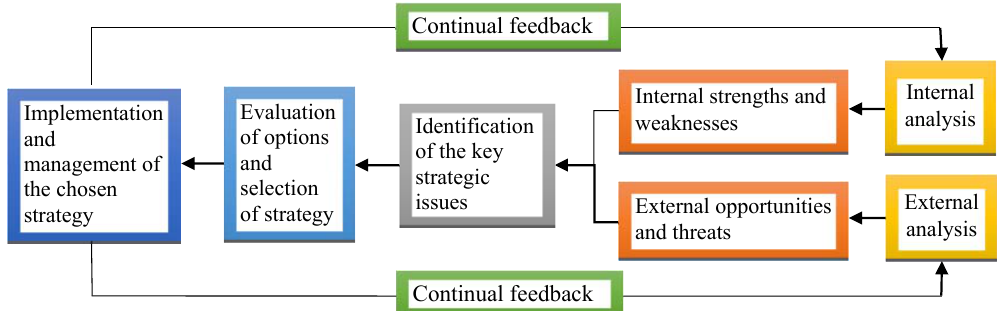
Fig. 1: The process of SWOT (Riston, 2008)